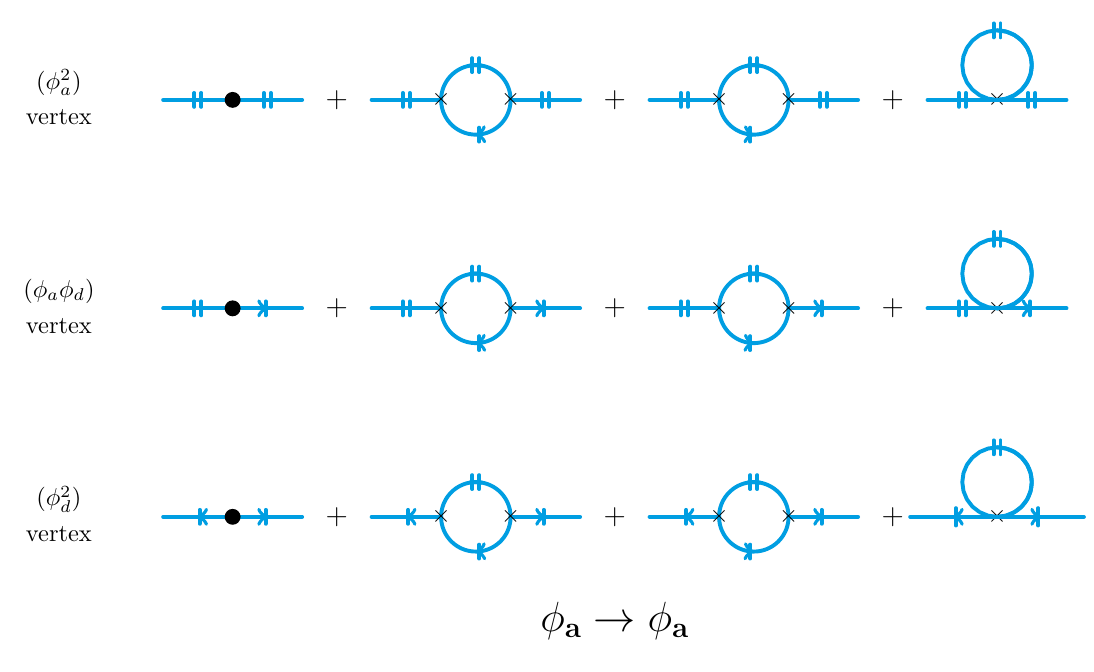
Figure 34. Mass renormalization in the average-di(cid:11)erence